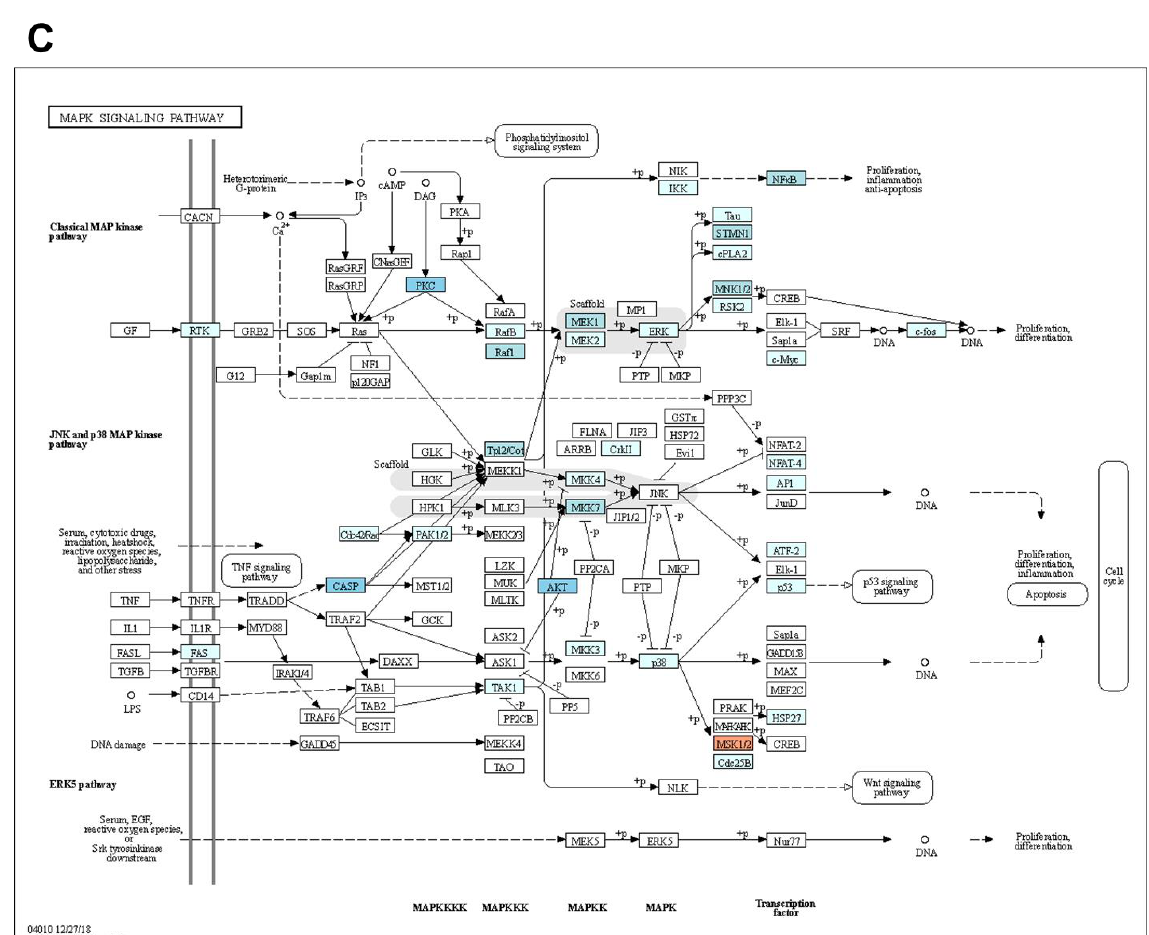
Figure 5. Antibody array analysis. ( A ) Fluorescence images of the antibody arrays. ( B ) Scatter plots of fluorescence signals; intensities of the control sample were plotted on the x-axis, and intensities of the test sample were plotted on the y-axis. Red and green lines indicate a 1.5-fold increase and decrease in fluorescence intensities, respectively, compared with the control sample. ( C ) The Kyoto Encyclopedia of Genes and Genomes (KEGG) pathway map for MAPK/ERK kinase (MEK)/extracellular signal-regulated kinase (ERK) pathway identified by antibody array analysis. Blue color indicates upregulated molecules. The KEGG pathway map was kindly provided by Kanehisa Laboratories (Kyoto University, Kyoto, Japan).